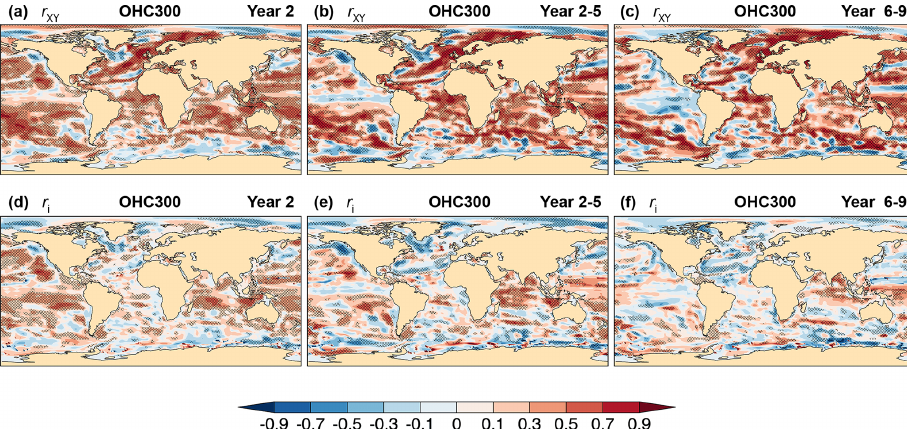
= σ 2 /σ 2 attributed to initialization for forecast (a, d) Year 2, Y i Y e i